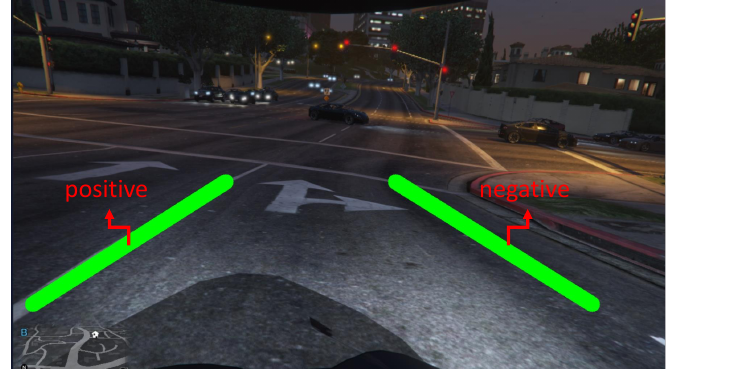
Figure 5. Lane detection algorithm.